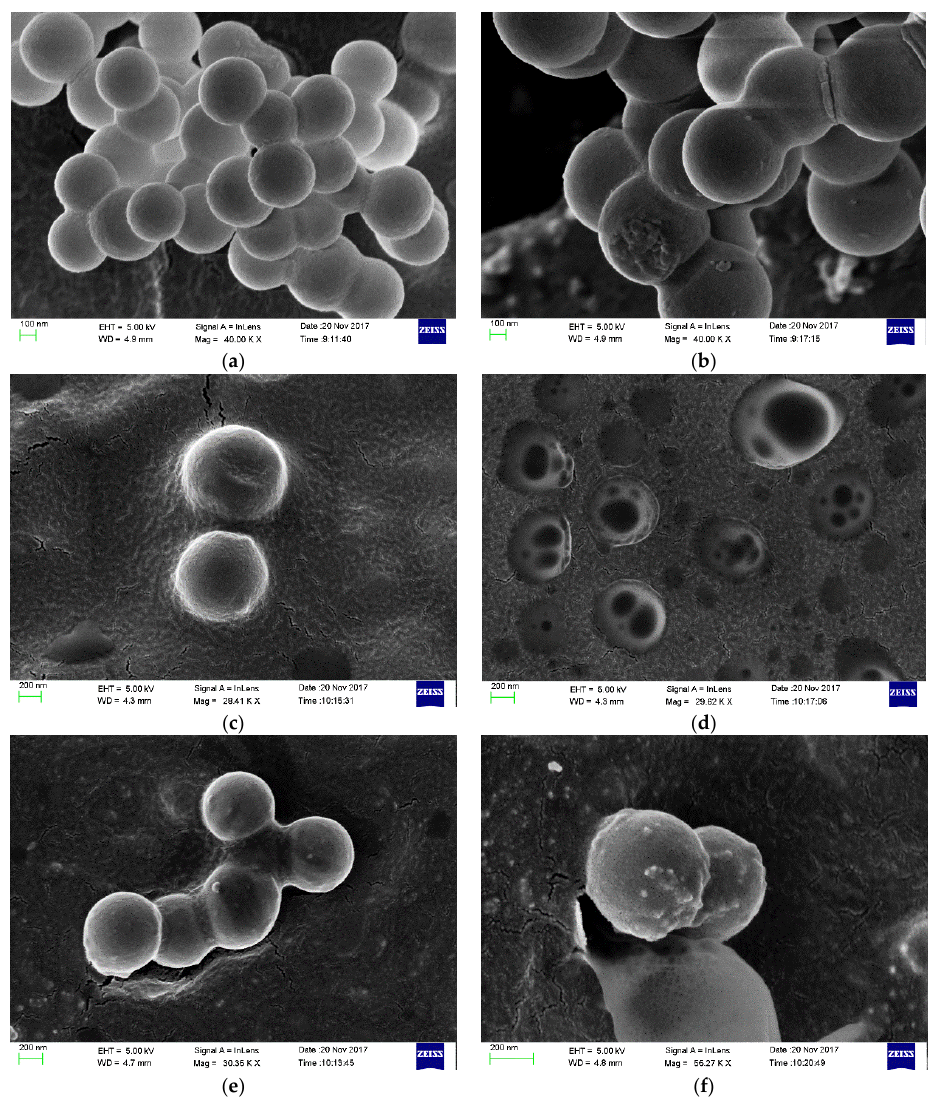
Figure 13. The SEM image of section of samples. ( a ) CMSs; ( b ) OCMSs; ( c ) PUA/FCMSs-3; ( d ) PUA/FCMSs-3; ( e ) PUA/OCMSs; ( f ) PUA/OCMSs.